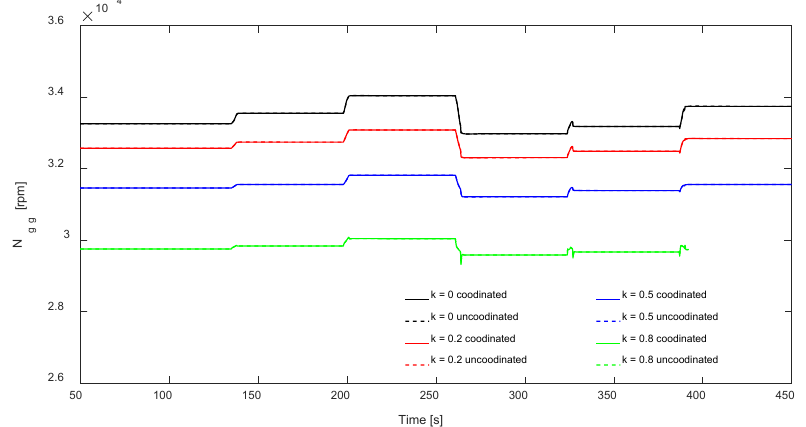
Figure 12. Effect of k and coordination on gas generator speed.